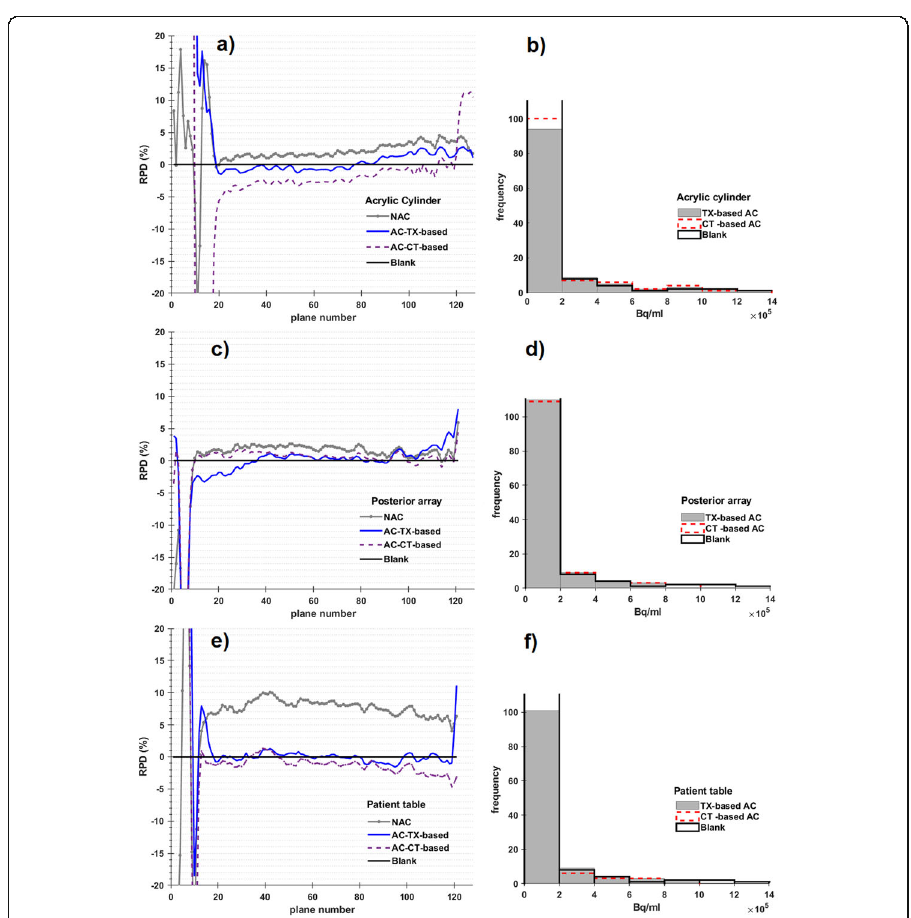
Fig. 4 RPD of NAC, TX-based AC, and CT-based AC PET images for the acrylic cylinder, posterior array, and patient table are shown in a , c and e, respectively, compared to blank. Distribution of photon counts are displayed in histograms in b , d , and f comparing TX-based AC to CT-based AC and